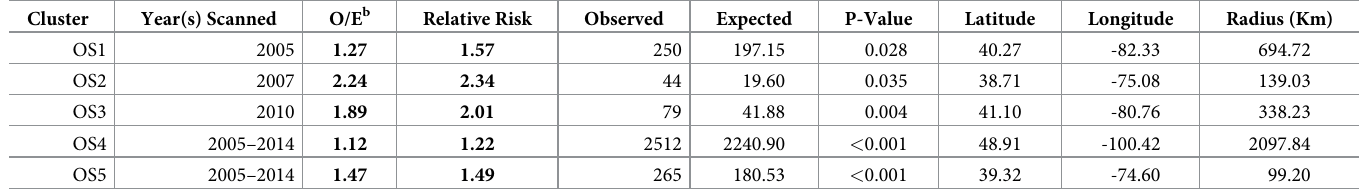
Table 3. Purely spatial clusters identified with the spatial scan statistic using Bernoulli models, where there were statistically significant higher proportions of dog- associated poisoning calls to the APCC a related to opioids in the continental US (2005–2014). Cluster